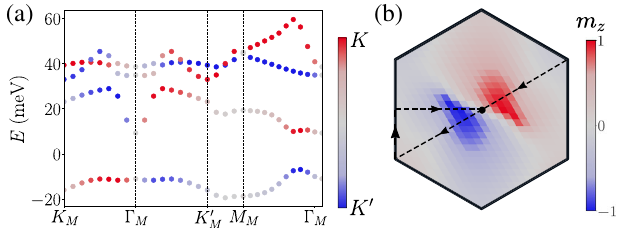
FIG. 5. (a) Band structure of the IKS state at ν ¼ − 2 , with color indicating the valley polarization of the HF orbitals.) b) z component of the vector m ð Eq. (6). Dashed lines indicate mBZ path in (a). In both plots, e k refers to the valley-dependent boosted momentum